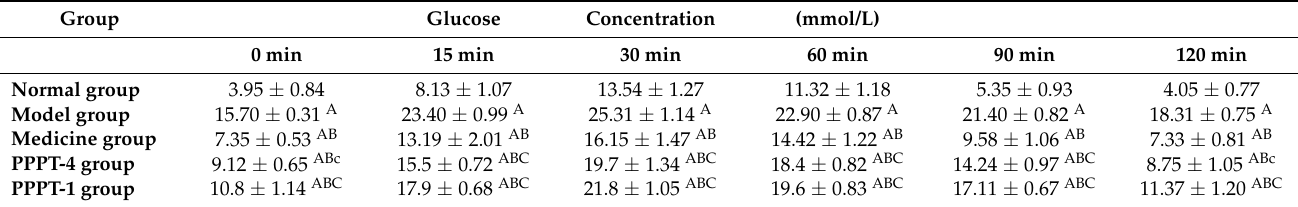
Table 5. Effect of PPPT on glucose tolerance of type II diabetic mice.